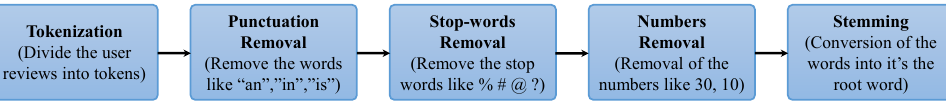
Figure 4. Steps followed in the pre-processing of the